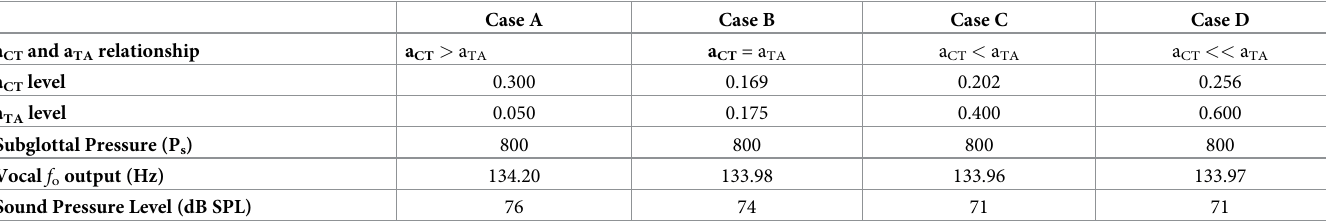
Table 4. Initial laryngeal intrinsic muscle activation levels applied for simulations. a LC was kept fixed at 0.5 for all